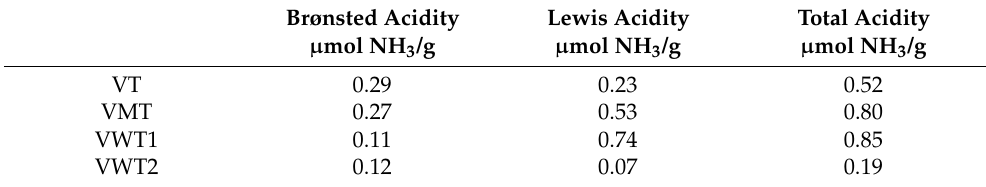
Figure 5. ( a ) The H 2 -TPR profiles of four catalysts. ( b ) The NH 3 -TPD profiles of four catalysts. Table 4. The adsorption amount of NH 3 at different